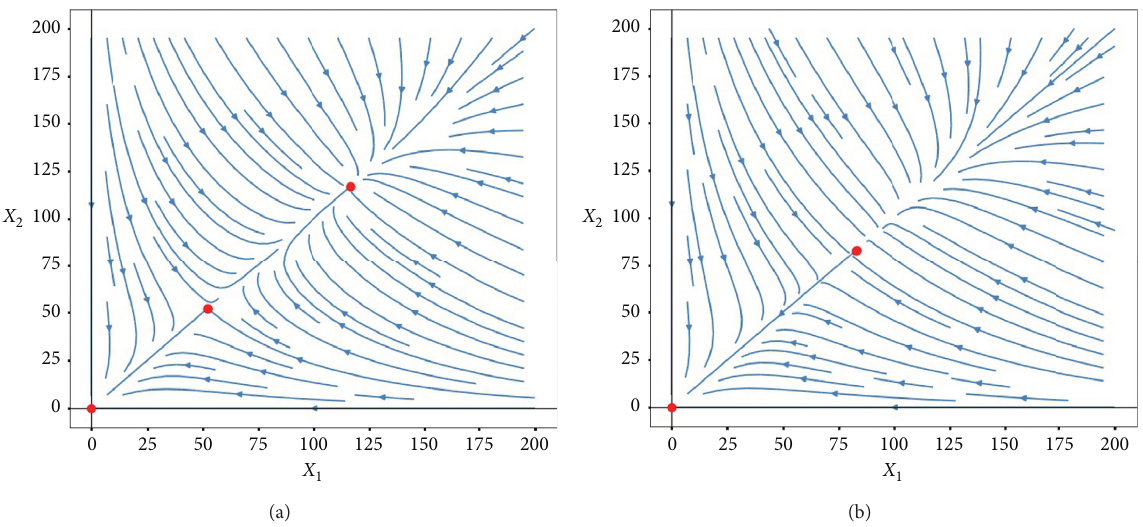
Figure 9: Obligate-obligate mutualism with competition in two populations: (a) we have the case where b that intraspecific competition is lower than mutualism; (b) we have b stronger effects than mutualism. Here, r